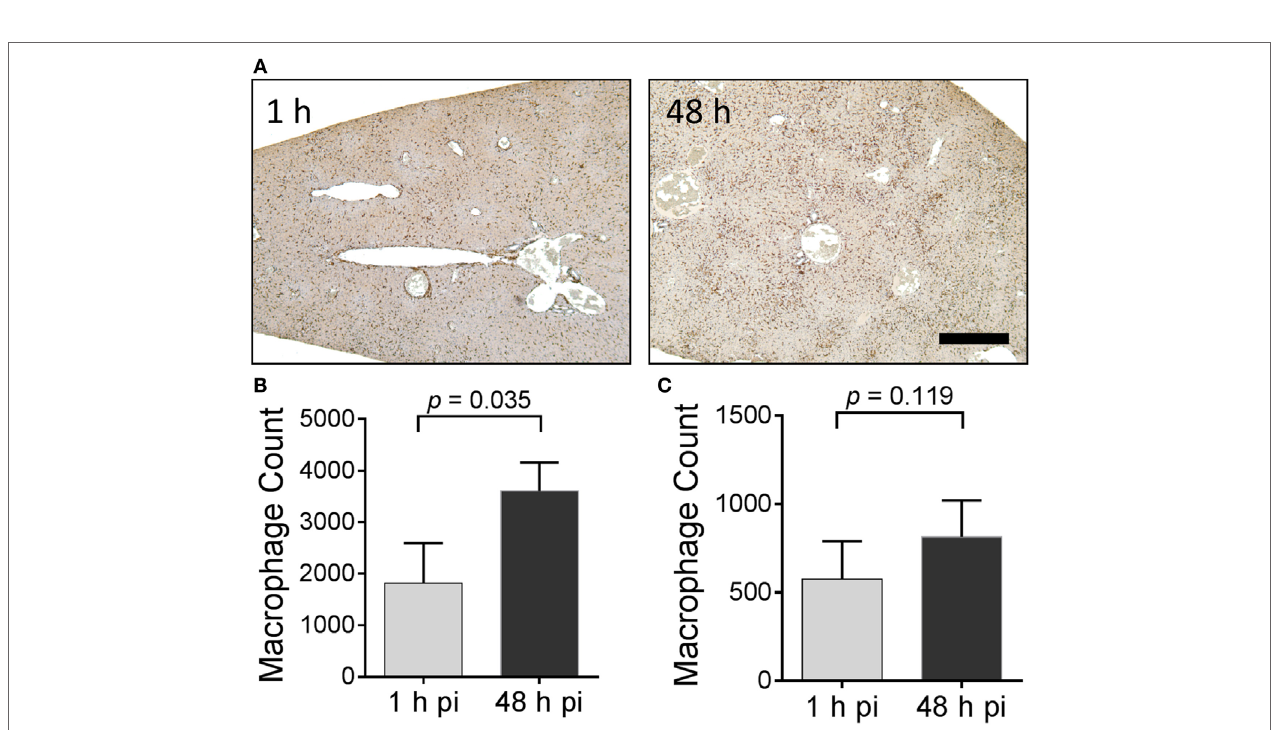
FigUre 8 | Administration of Fcp5 enhances hepatic macrophage number over 48 h in AA mice but not wild-type (WT) mice. (a) Formalin-fixed liver tissue from mice at 1 and 48 h postinjection of Fcp5 was immunostained with Iba-1-reactive monoclonal antibody and the number of immunopositive cells quantified by image segmentation. The bar is 300 pixels in length. Comparison (two-tailed t -test) of hepatic macrophage number in AA (B) and WT (c) mice at 1 and 48 h postinjection of Fcp5. Mean ± SD, n = 3.